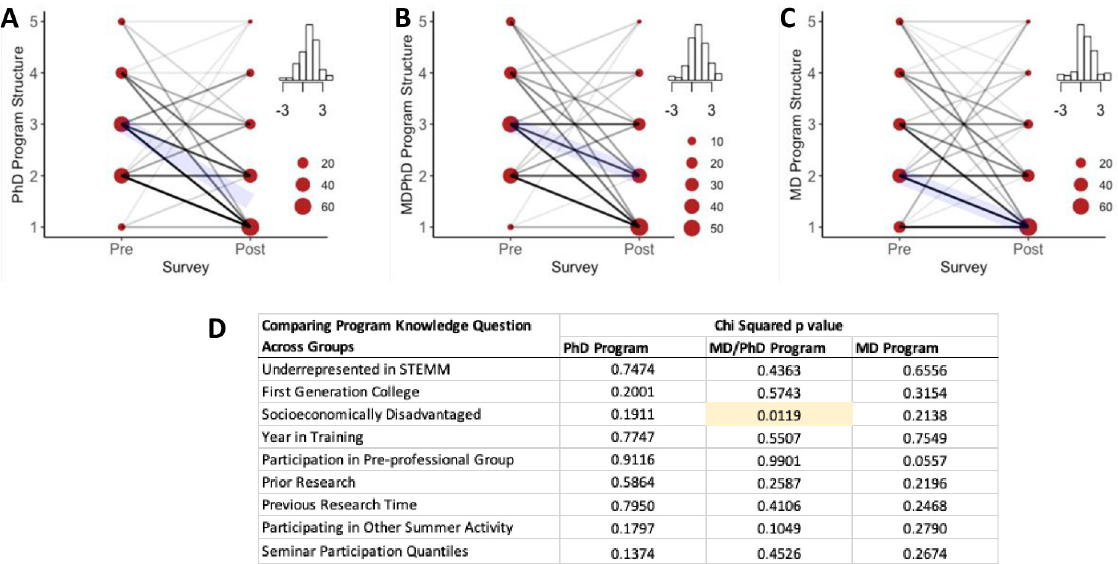
Fig 3. Participation in the virtual VSSA program increases Ph.D., MD, MD/Ph.D. program knowledge. (A-C) The inset is a histogram of the change in values (pre-test minus the post-test value) with the highest bar at 0, indicating no change in response. Positive changes indicate increased agreement with the statement. (A) First, we examined student responses to the prompt "I have an understanding of the program structure for a Ph.D. program." The average pre-survey response was "neutral," but following the program, most students responded between "agree" to "strongly agree." (see purple highlight line, indicating median value for each survey). (B) Similarly to the prompt "I have an understanding of the program structure for an M.D./PhD program," student pre-survey response was "neutral" however, following the program, most students responded "agree." (C) To the prompt, "I have an understanding of the program structure for an MD program," in the pre-survey, most students responded "agree," but following the program, most students responded, "strongly agree." (D) Finally, we examined only the groups who had a positive change in understanding of the Ph.D., MD/Ph.D., and M.D. programs with positive identification with the groups listed on the first column. There was a positive correlation between a positive change in belonging score